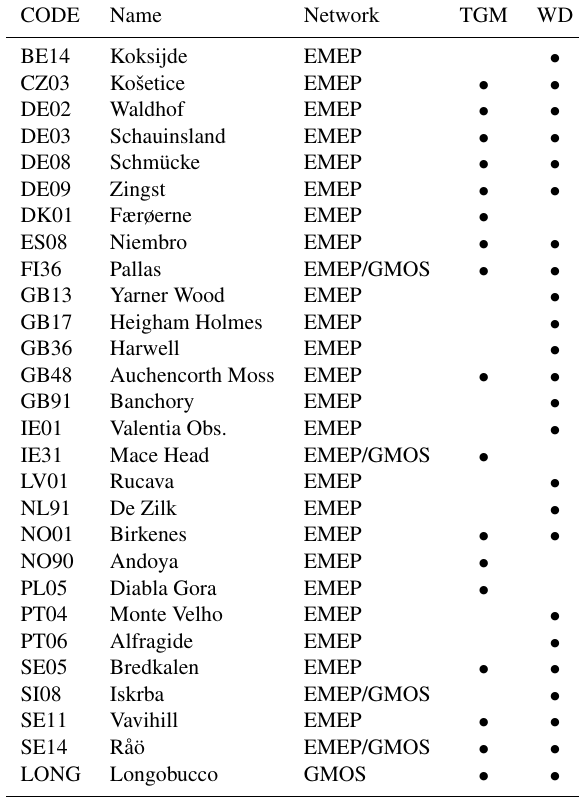
Table 2. List of observation points.